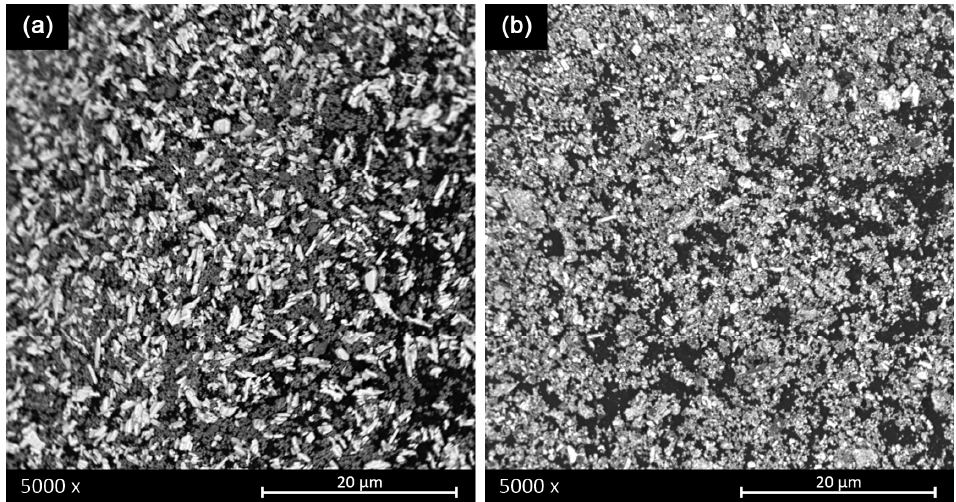
Figure 2. ( a ) XRD diffraction patterns of the powder ball-milled for 6 h and calcined under variable time and temperature. Symbols indicate the secondary phases that accompany the main Barium Calcium Zirconium Titanate (BCZT) perovskite. Vertical dotted lines indicate the main BCZT per- ovskite reflections that are marked with the Miller indexes for the tetragonal prototype. ( b ) Rietveld analysis of the calcined powder at 700 °C for 2 h, in which both BCZT and Calcium Titanate (CTO) stick patterns are